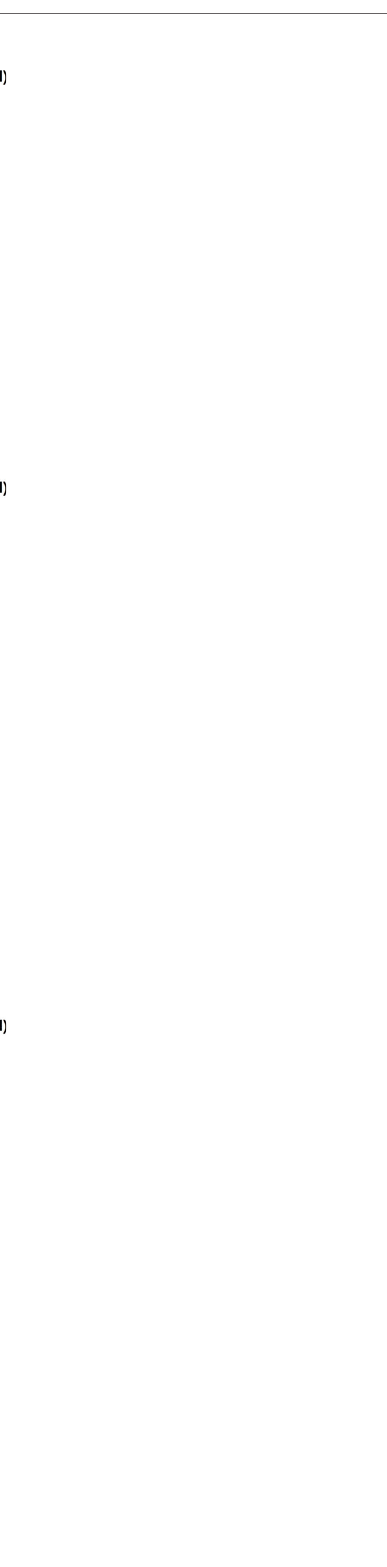
FIGURE 3 | Forest plot of the relative effects compared with BEV. All therapies were compared with BEV in 3 outcomes: (A) ORR, (B) 6-m PFS rate, and (C) OS. The size of every solid square is proportional to the total sample size. The abbreviations are de fi ned in the legend of Figure 2